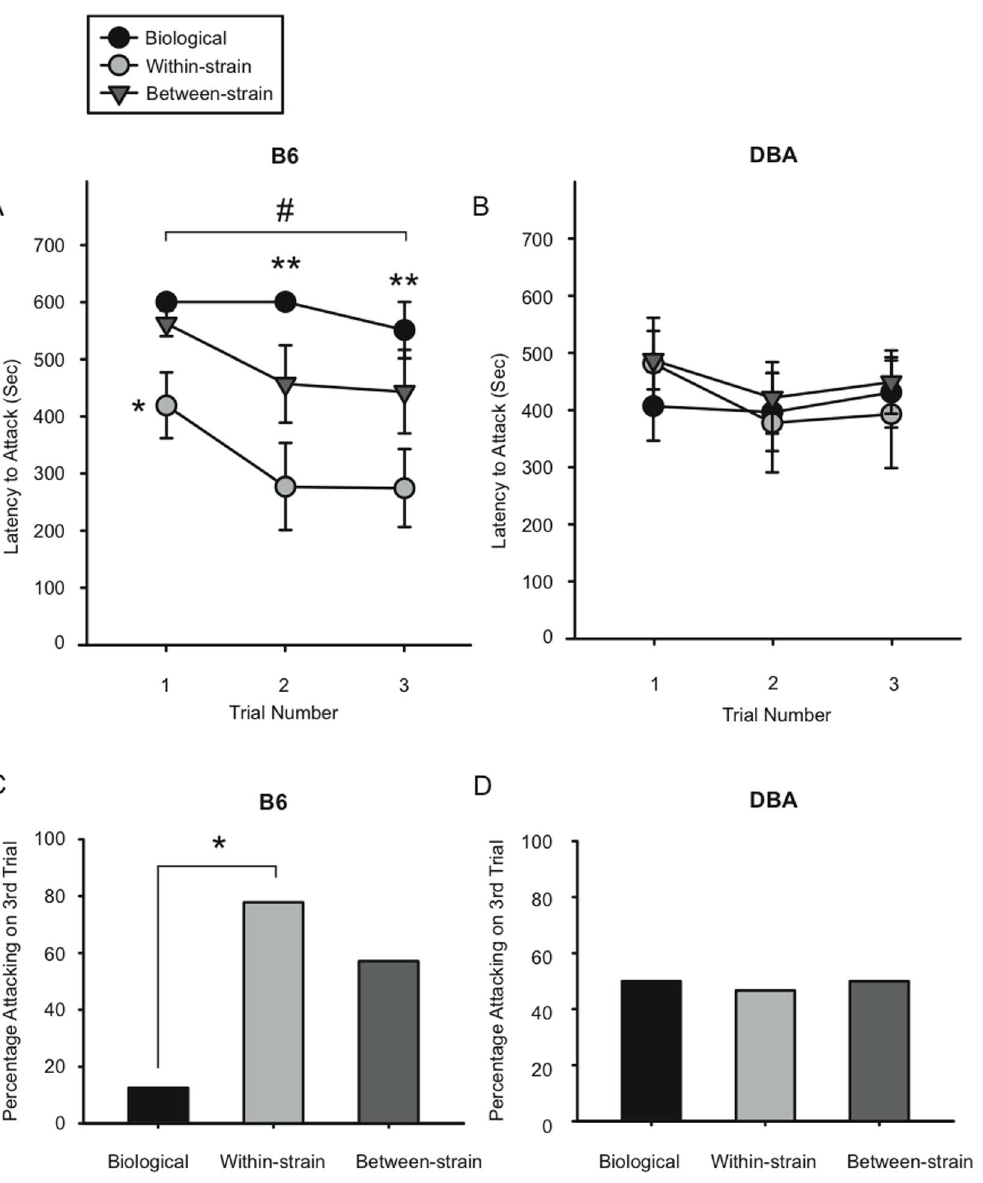
Figure 2. Fostering influences aggressive behavior in B6 male mice. (A, B) Mean ( + /- SEM) attack latencies (in seconds) on each aggression trial for B6 (A) and DBA (B) male offspring. B6 males reared by their biological dams took significantly longer to attack intruders than within-strain and between-strain fostered males (p , 0.0002). * Within-strain fostered B6 males had significantly shorter attack latencies than those reared by biological dams on the first trial. ** B6 males reared by biological dams had significantly longer attack latencies than within-strain and between-strain fostered B6 males on the second and third trials. # Latencies to attack on the first trial were longer than those on the second and third trials (p , 0.004). (C, D) Percentage of individuals attacking on the third aggression test for B6 (C) and DBA (D) male offspring. * Percentage of attacking males was significantly higher in the within-strain fostered B6 group than the biological B6 group (p=0.0304).